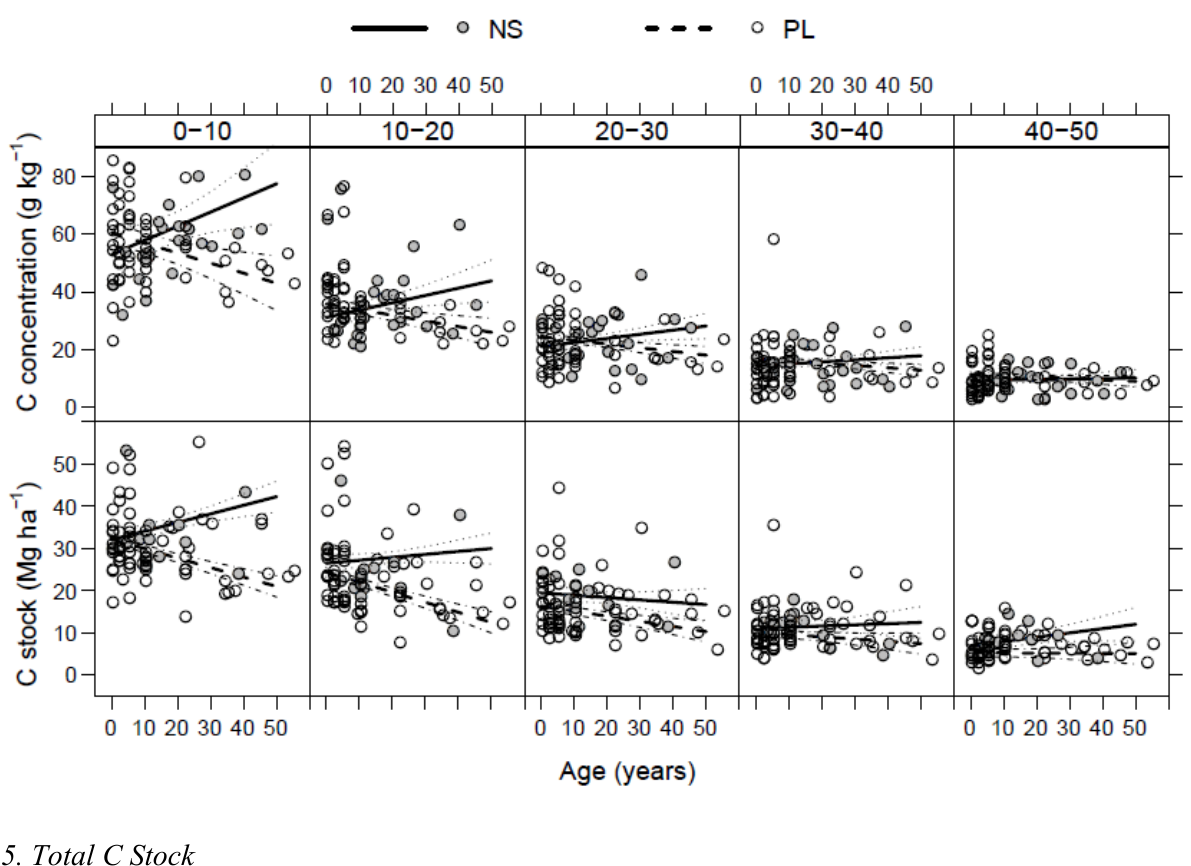
Figure 5. Soil C concentrations and stocks according to site age, fallow site type (plantation [PL] and natural succession [NS]), and soil depth (10-cm layers from 0–10 to 40–50 cm). Lines show model predictions and their SE; dots show site